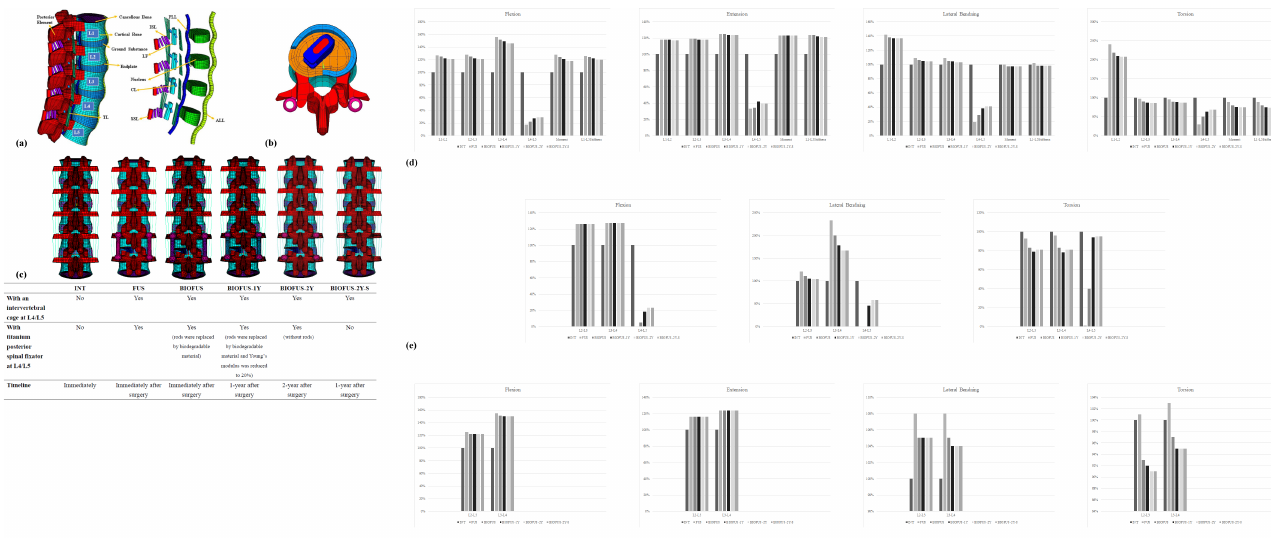
Fig 1. FE models of the spine with and without implants. a) The osseous structures, intervertebral discs, and ligaments of the intact spine. b) At the L4-L5 disc space, the cage was placed obliquelywith the left posterolateral corner of the annulusfibrosus removed, as in PLIF procedures.c) Six FE models used in this study. The d) ROM, e) facet joint forces, f) disc stresses of all models normalized by the INT model.